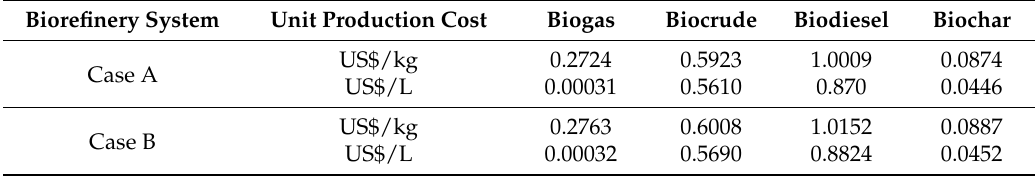
Table 8. Mass flow rate of useful products from the proposed biorefinery